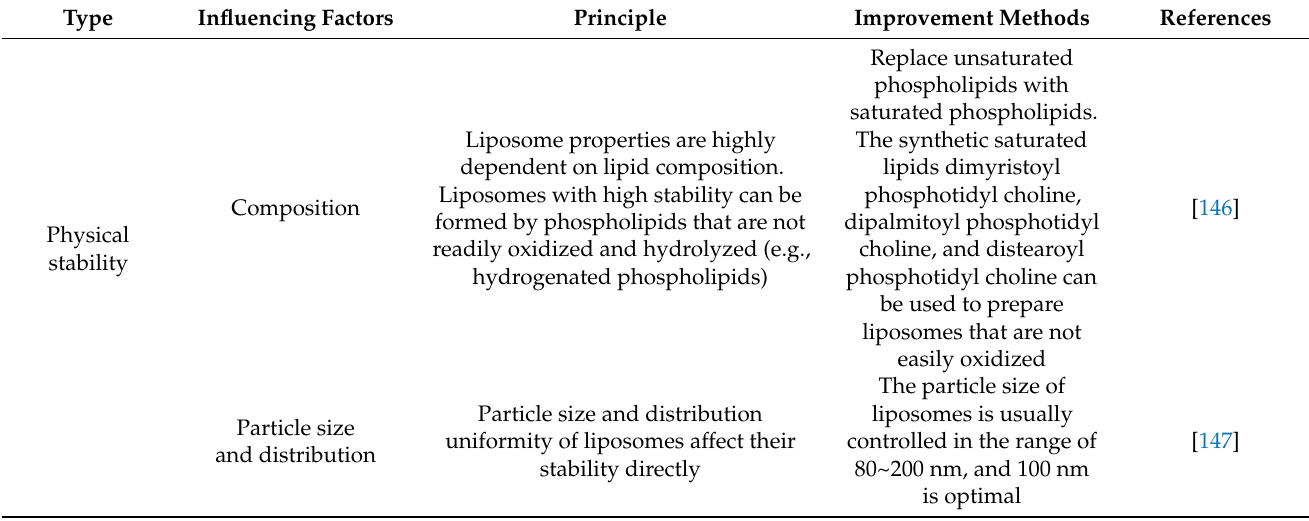
Table 5. Influencing factors of physical and chemical stability of